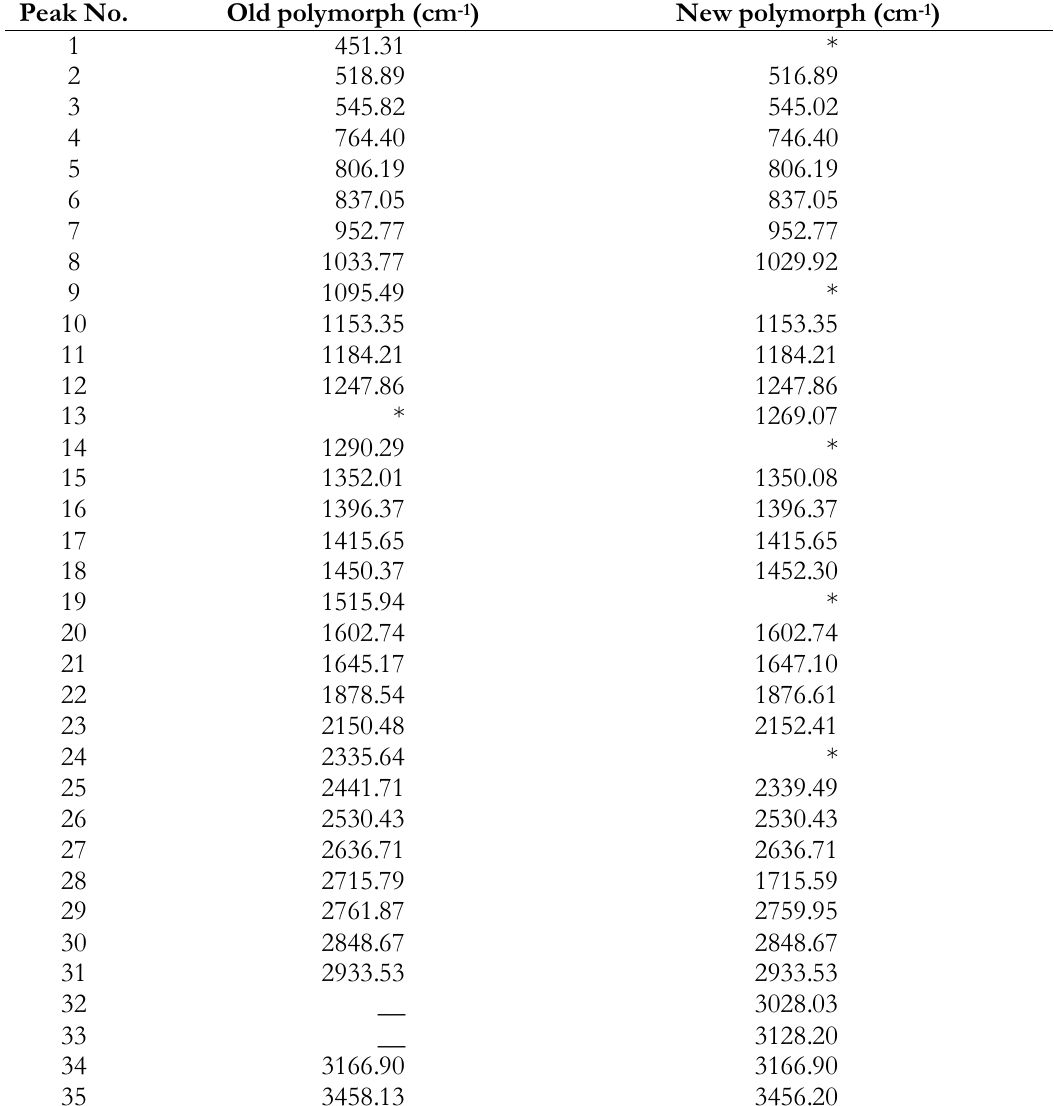
Table II. Comparative IR chart showing peaks for old and new polymorphs Peak